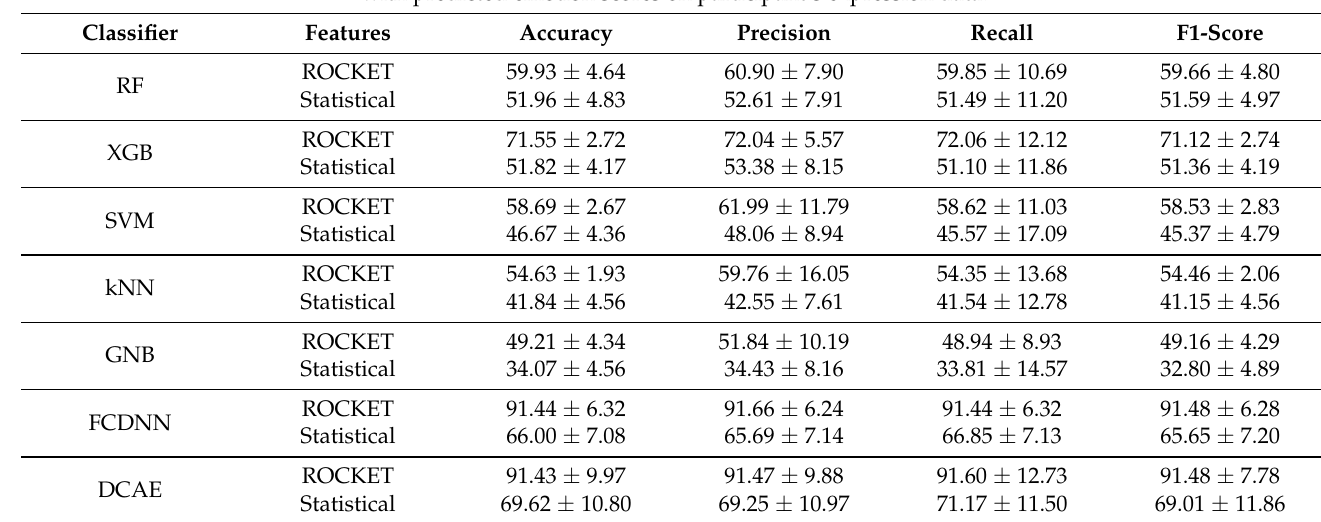
( b ) Classification results for DS2: Brain data acquired from fNIRS appended with predicted emotion scores on participant’s expression data.